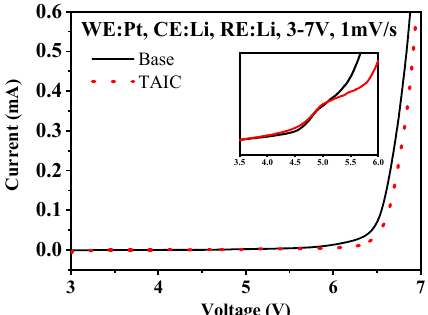
Figure 2. LSV curves of the three-electrode setup in different electrolytes (Inset: Base-1# and TAIC-2#) (The scanning voltage ranged from OCV to 7 V, and the scan rate was 1 mV/s).